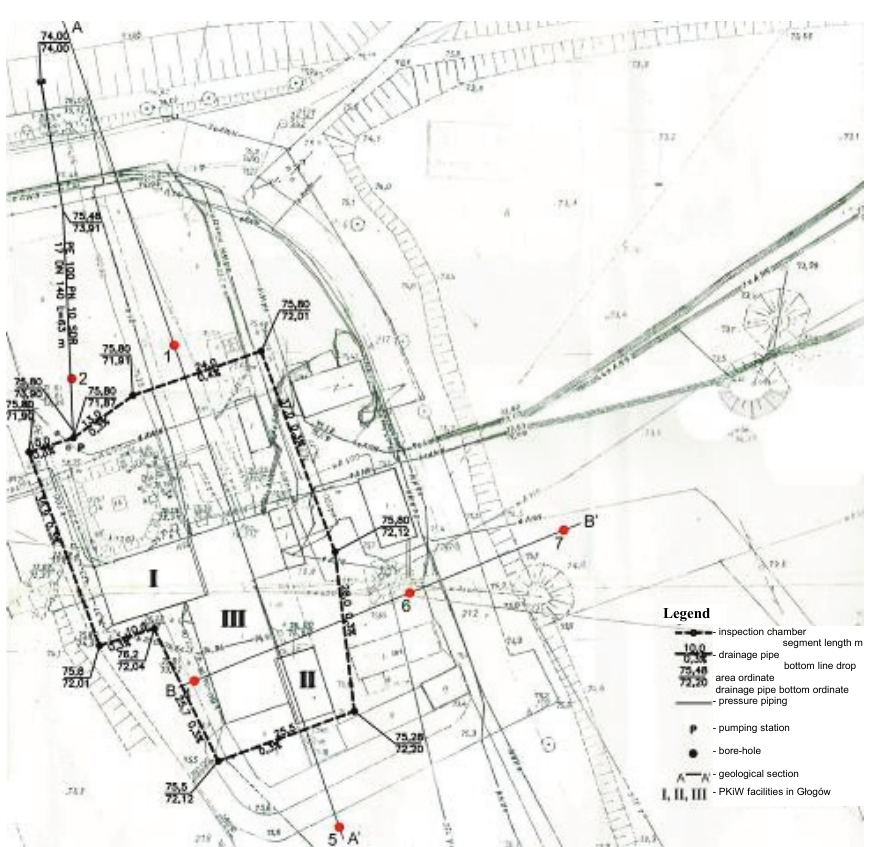
Fig. 5. Draining by means of a non-deepened drainage – variant